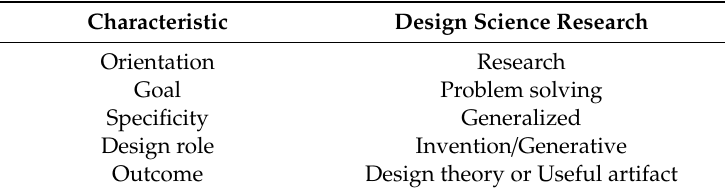
Table 3. Characteristics of design science